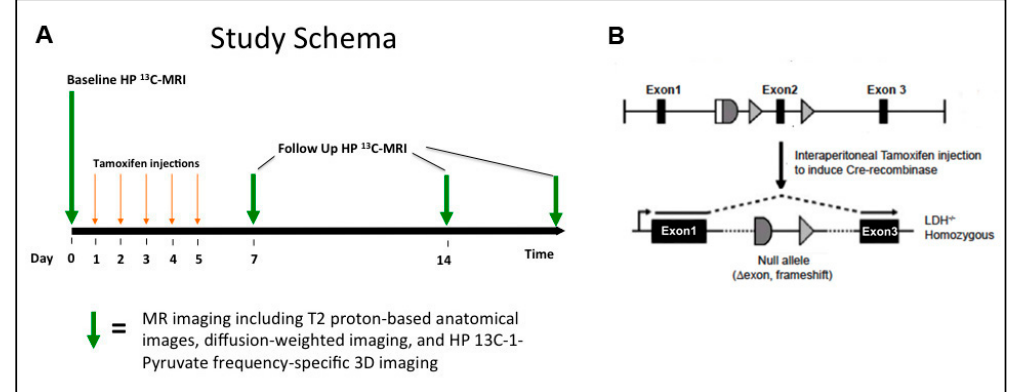
Figure 1. ( A ) Schematic of the study design for lactate dehydrogenase-A (LDHA) knockout studies. Multi-parametric 1 H and HP 13 C magnetic resonance imaging (MRI) exams performed pre- and post-LDHA knockdown. ( B ) Schematic of LDHA gene knockdown induced by tamoxifen administration.